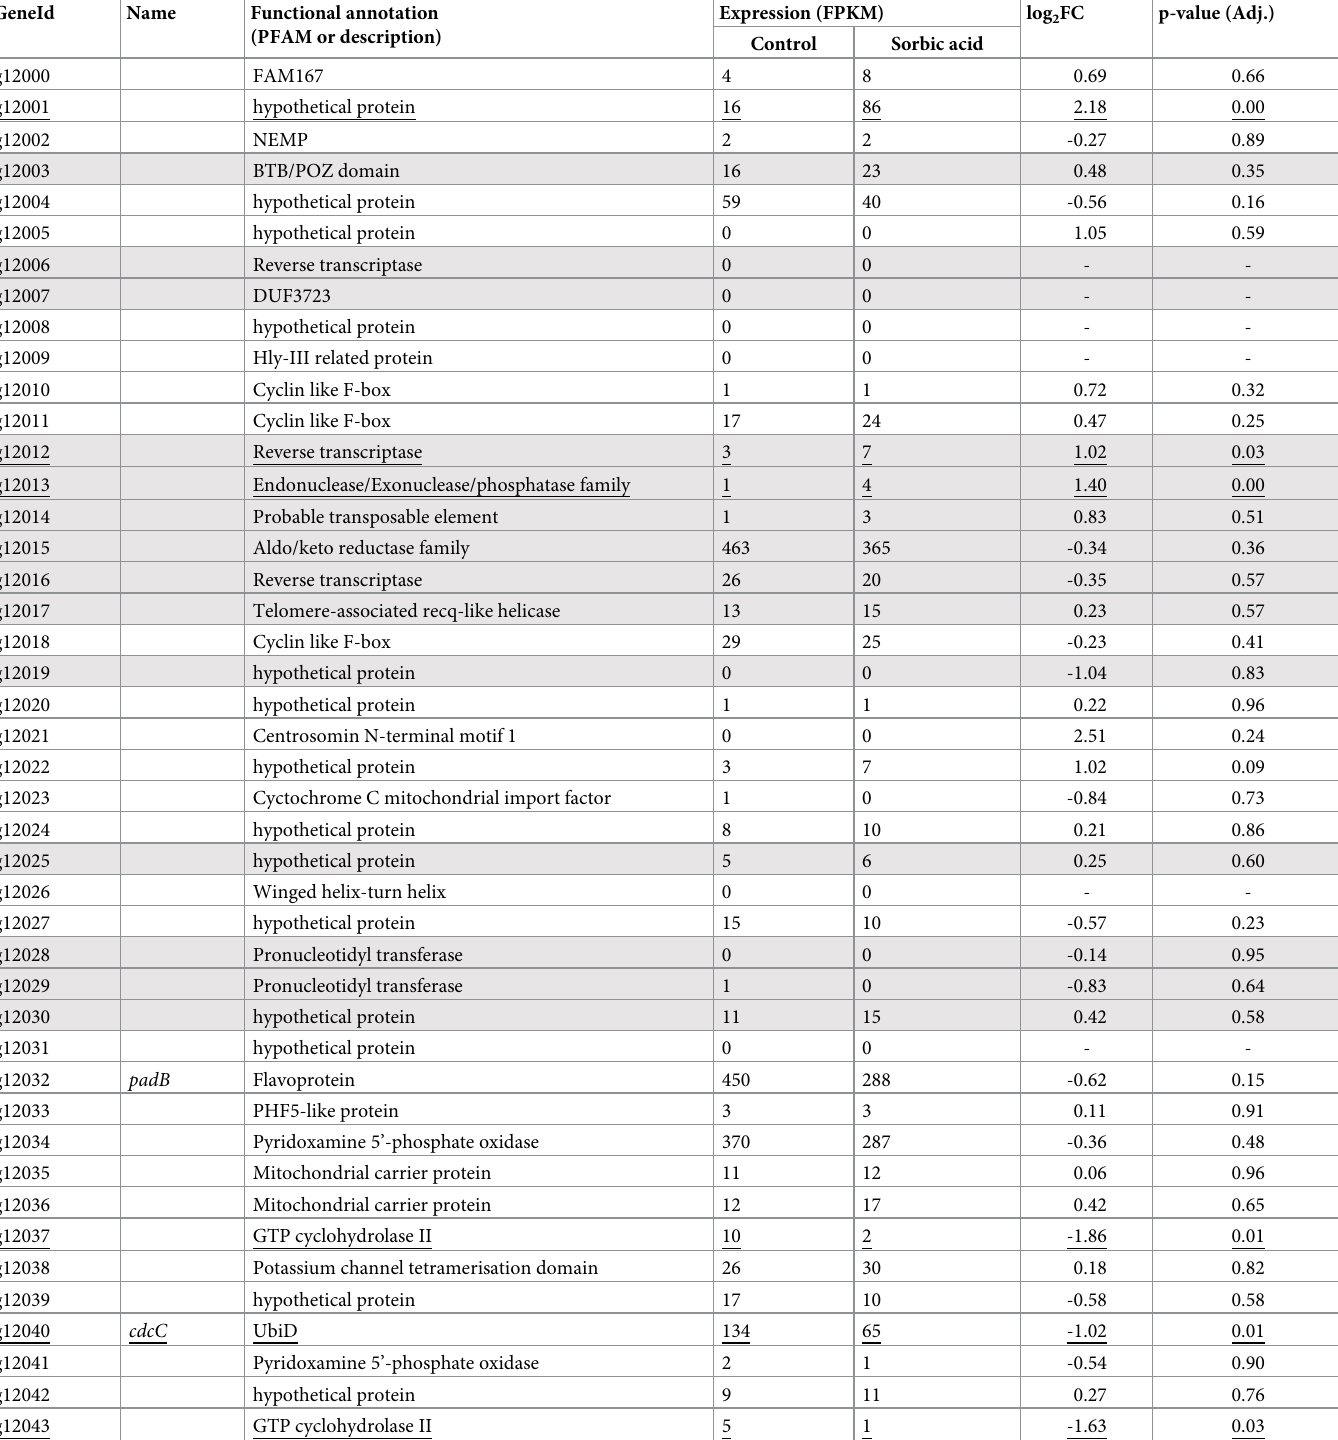
Table 2. Genes located on the SORBUS cluster in strain DTO006G7. Fold change (log 2 FC) of the sorbic acid samples compared to the control is given. Underlined genes are significantly differentially expressed (adjusted p-value < 0.05) and the mean expression (FPKM) of three biological replicates is given per condition (control and sorbic acid). Rows highlighted in grey indicate genes that are not unique for the R-type